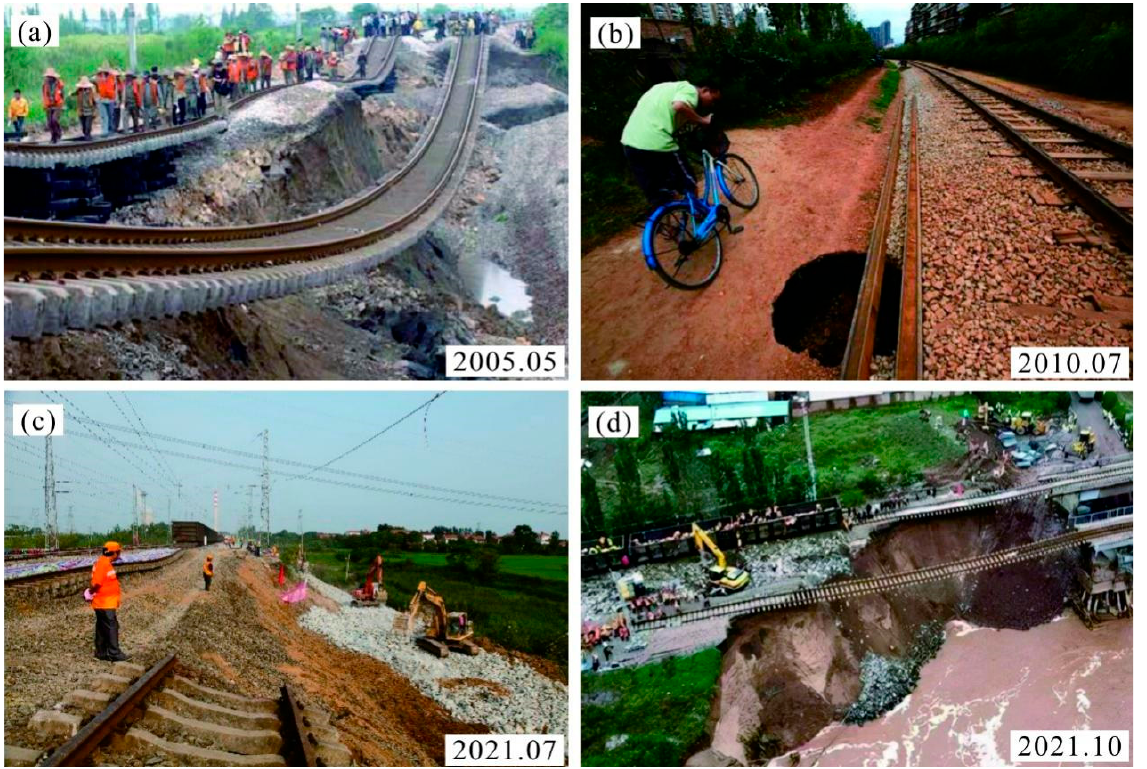
Figure 1. Typical high-speed railway foundation settlement disasters in China: ( a ) Xiaoyong railway collapse disaster; ( b ) Kunming railway collapse disaster; ( c ) Longhai railway collapse disaster; ( d ) South Tongpu railway collapse disaster.